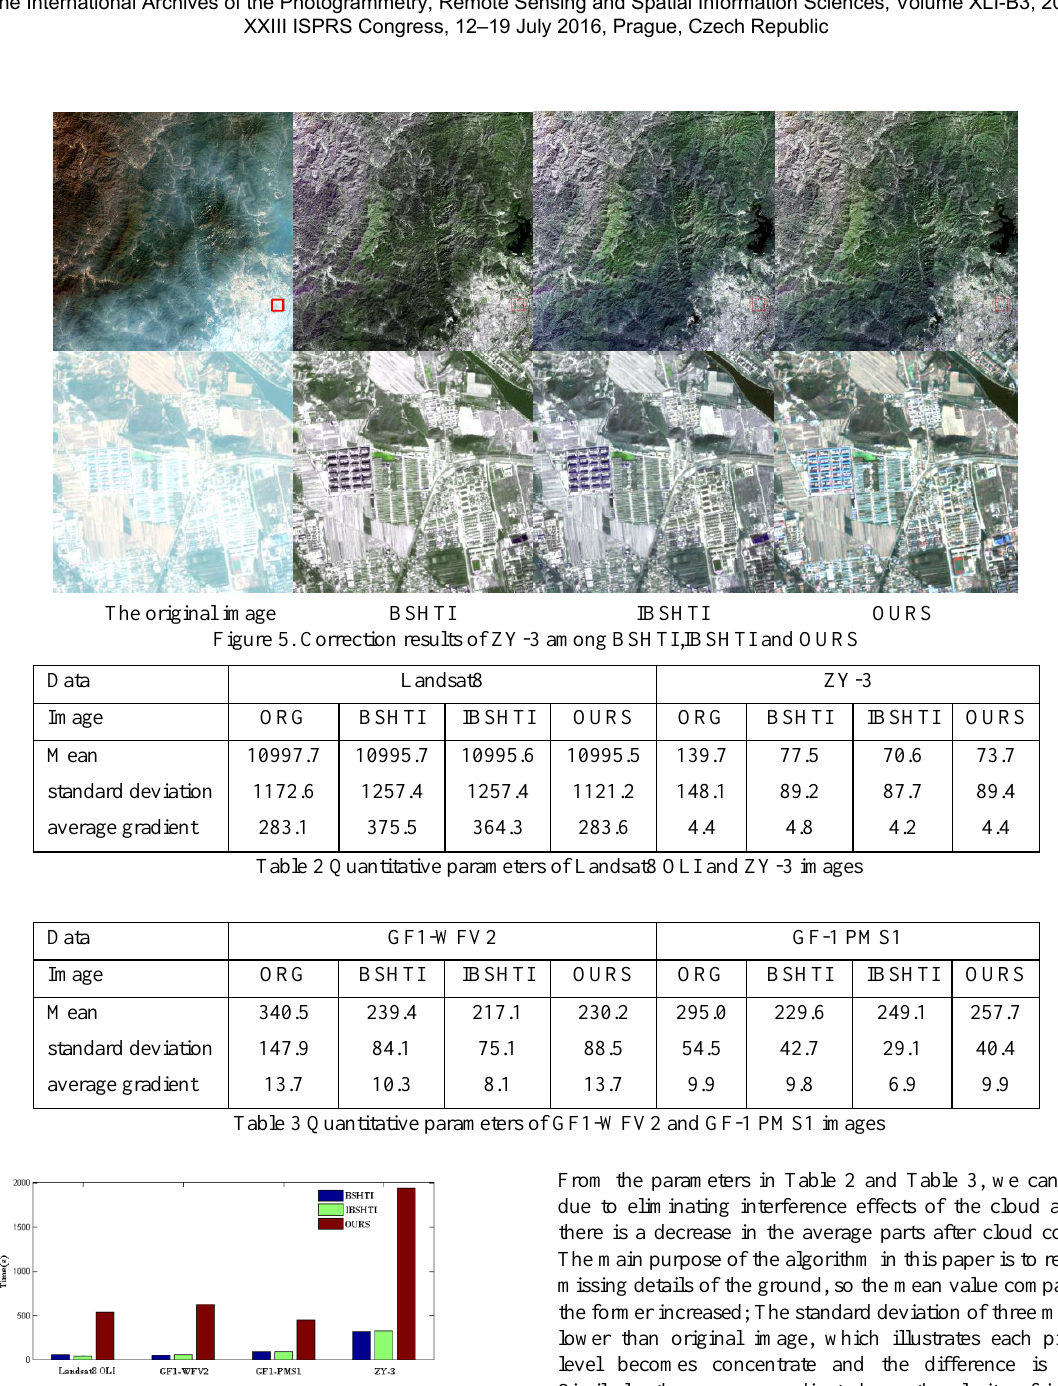
Figure 6. The running time of image